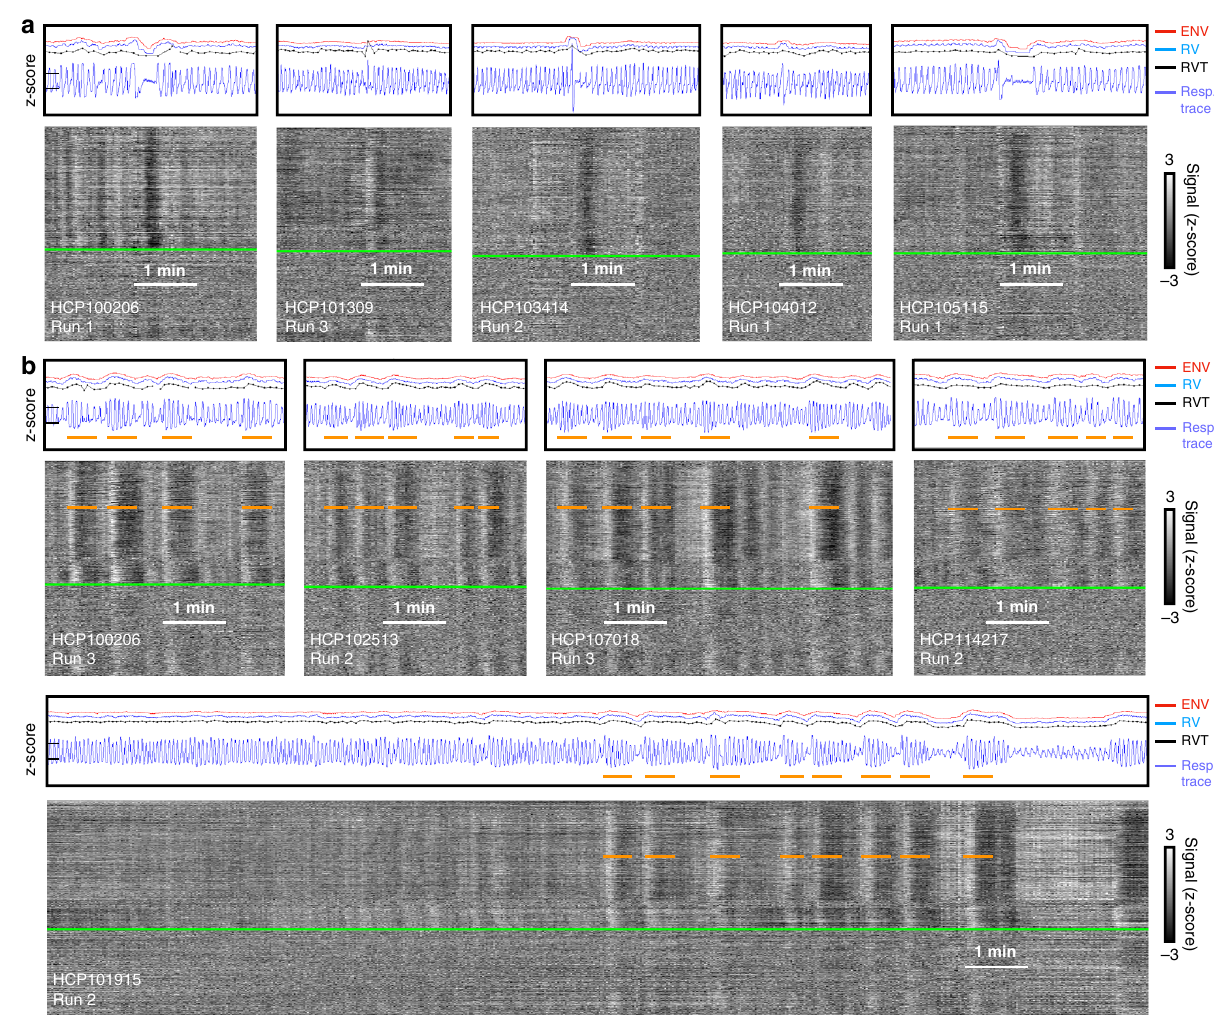
Fig. 2 Examples of deep breaths and bursts. Plots are formatted as in Fig. 1. Note in deep breaths a the slowness of the breaths, the possibility of transient apnea afterward, the incongruence of the respiratory measures ENV, RV, and RVT, and the presence of fMRI signal decreases in each instance. Note in bursts b the repeated, serial modulation of breathing amplitude, the congruency of ENV, RV, and RVT, and the rhythmic correlates in fMRI